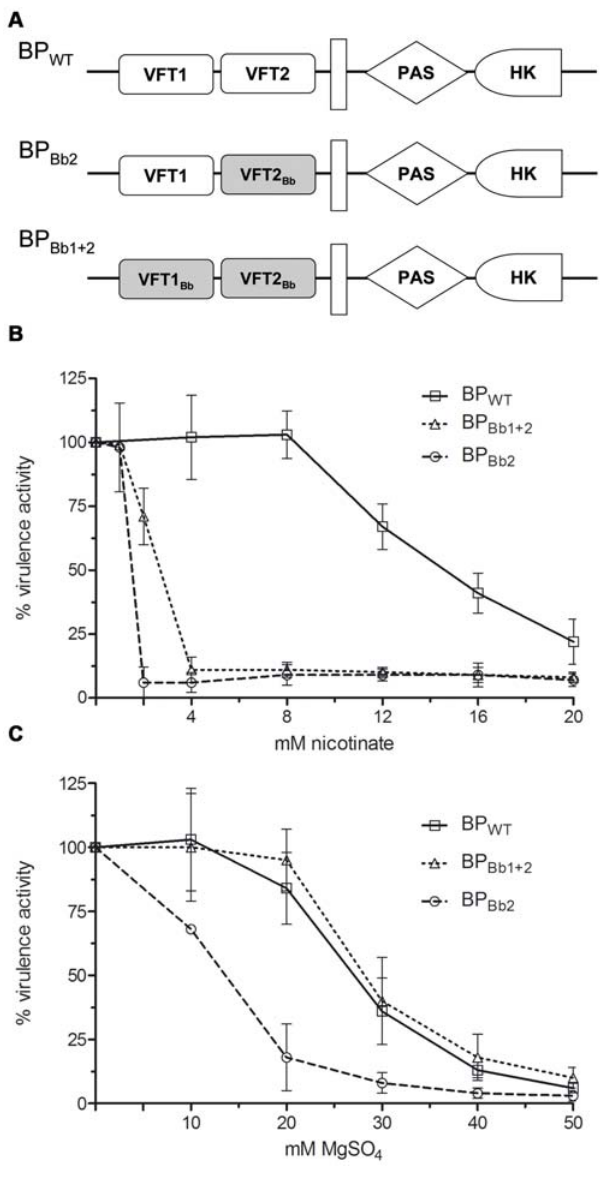
Figure 4. ß-galactosidase activities of the recombinant BPSM( ptx::lacZ ) strains harbouring BvgS variants. (A) Schematic representation of the chimeric BvgS, with the white boxes representing BvgS Bp domains and the shaded boxes BvgS Bb domains. BP WT corresponds to BPSM carrying the reporter gene. HK represents the His-kinase domain. (B) and (C) The ß-gal activities were measured as a function of increasing concentrations of nicotinate or MgSO 4 . The measurements were performed in triplicate using different clones for each recombinant strain. The level of ß-gal activity in non-modulated medium was taken as 100%.